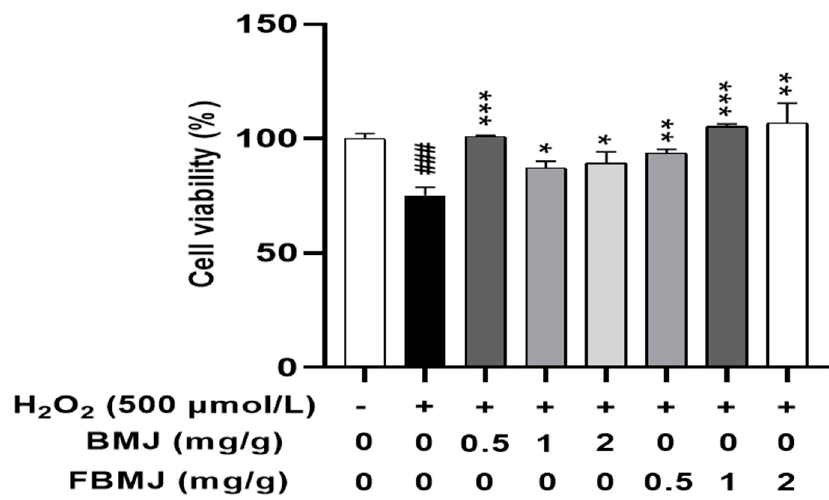
Figure 5. The effects of BMJ and FBMJ on the survival rate of 500 µ mol/L H 2 O 2 -oxidatively stimu- lated C2C12 cells compared with the control group (### p < 0.001) and damaged group (* p < 0.05, ** p < 0.01, *** p < 0.001.).